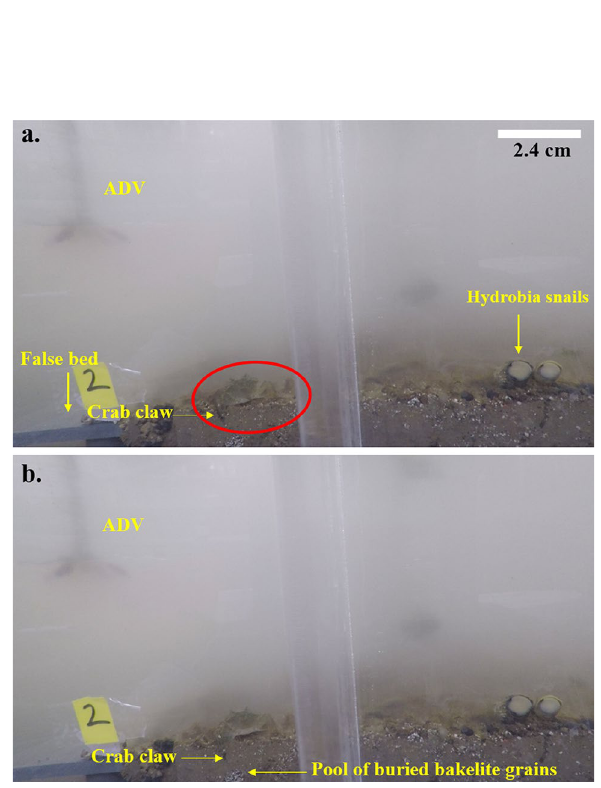
Figure 5. Burial of Bakelite particles by the burrowing crab Carcinus maenas . ( a ) Onset of the crab inserting its claw into the burrow it formed. ( b ) Extension of the claw to about 1 cm depth by the crab to reach the pool of Bakelite particles. This action continues repeatedly with particles sinking into the burrow (See Supplementary Video